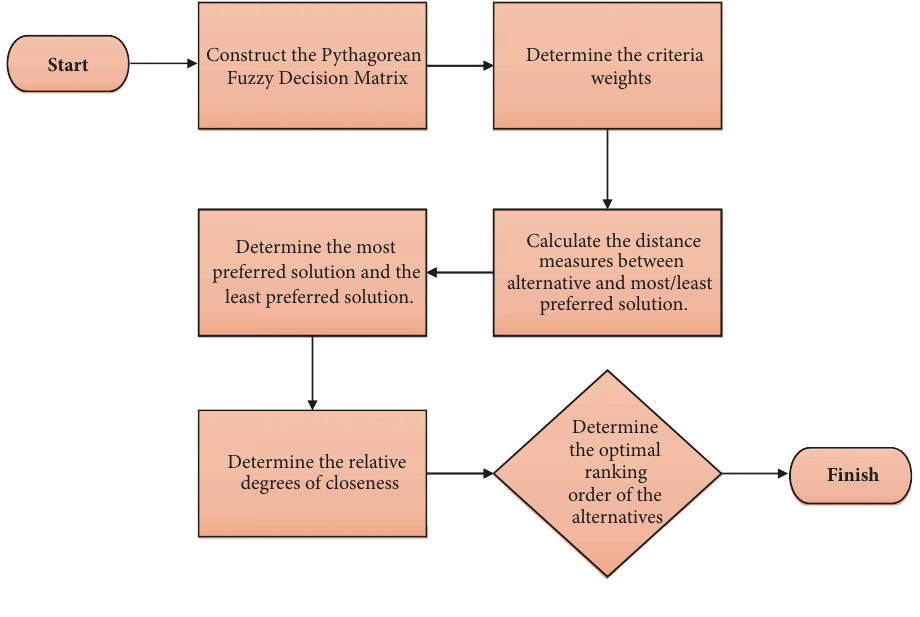
Figure 3: Flowchart of the proposed algorithm using